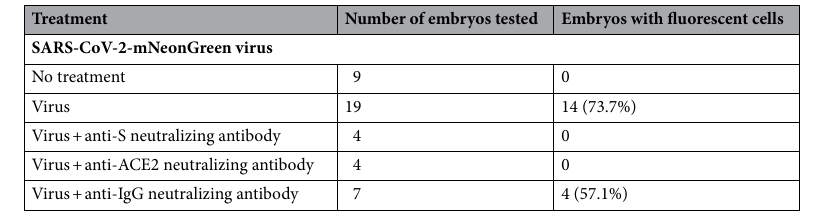
Table 2. Summary of experiments using live, fully-infectious SARS-CoV-2. The table indicates the experimental condition, the number of embryos used, and the number/percent of infected embryos as evidenced by fluorescent